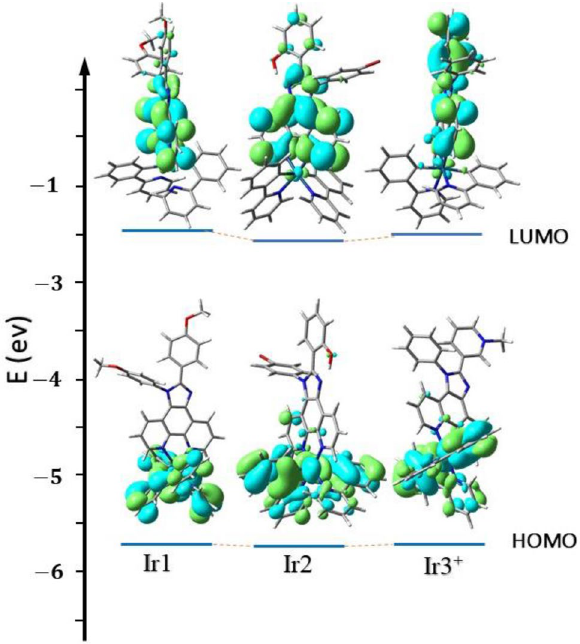
Figure 4. Energy levels and surface distributions of HOMO/LUMO orbitals at optimized S0 geometries computed for complexes Ir1-3 + .